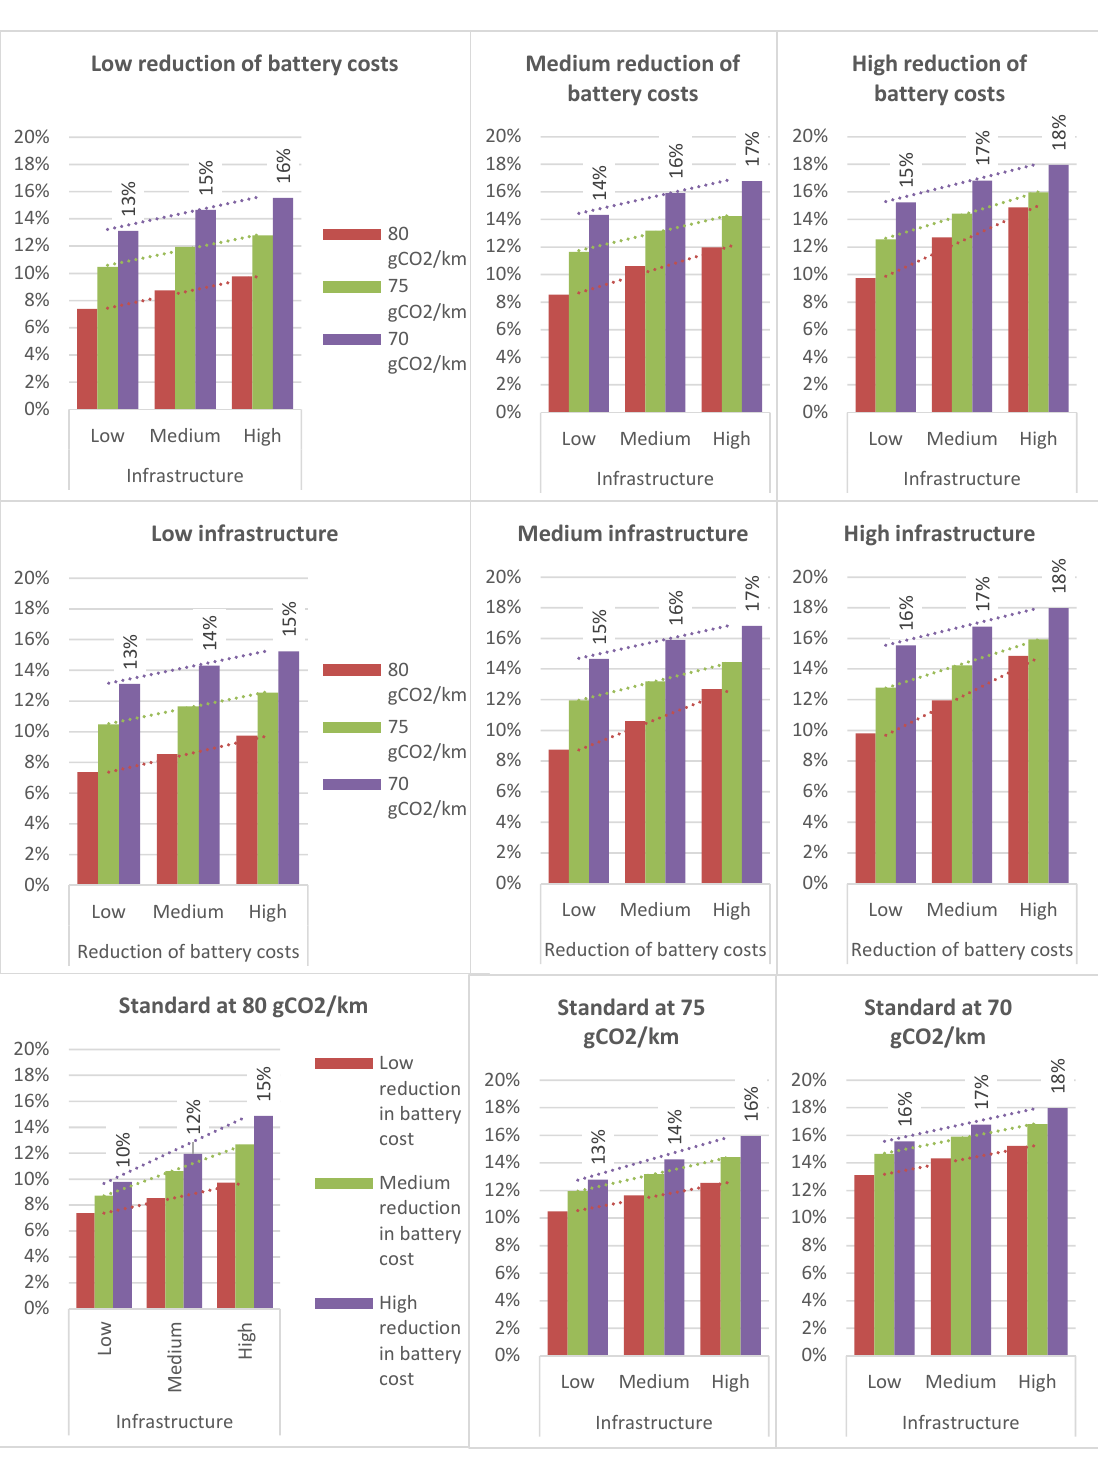
Figure 2. Shares of electric vehicles in the total car fleet in the EU by 2030, in various scenarios.